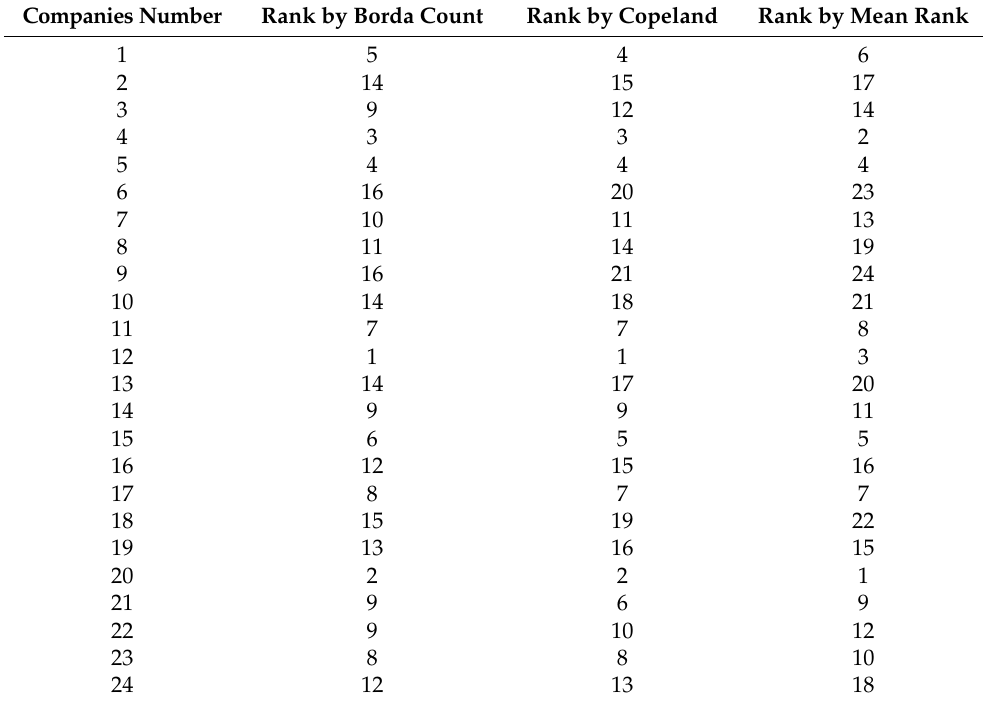
Table 5. Summarized results of mean rank, Borda count, and Copeland methods.